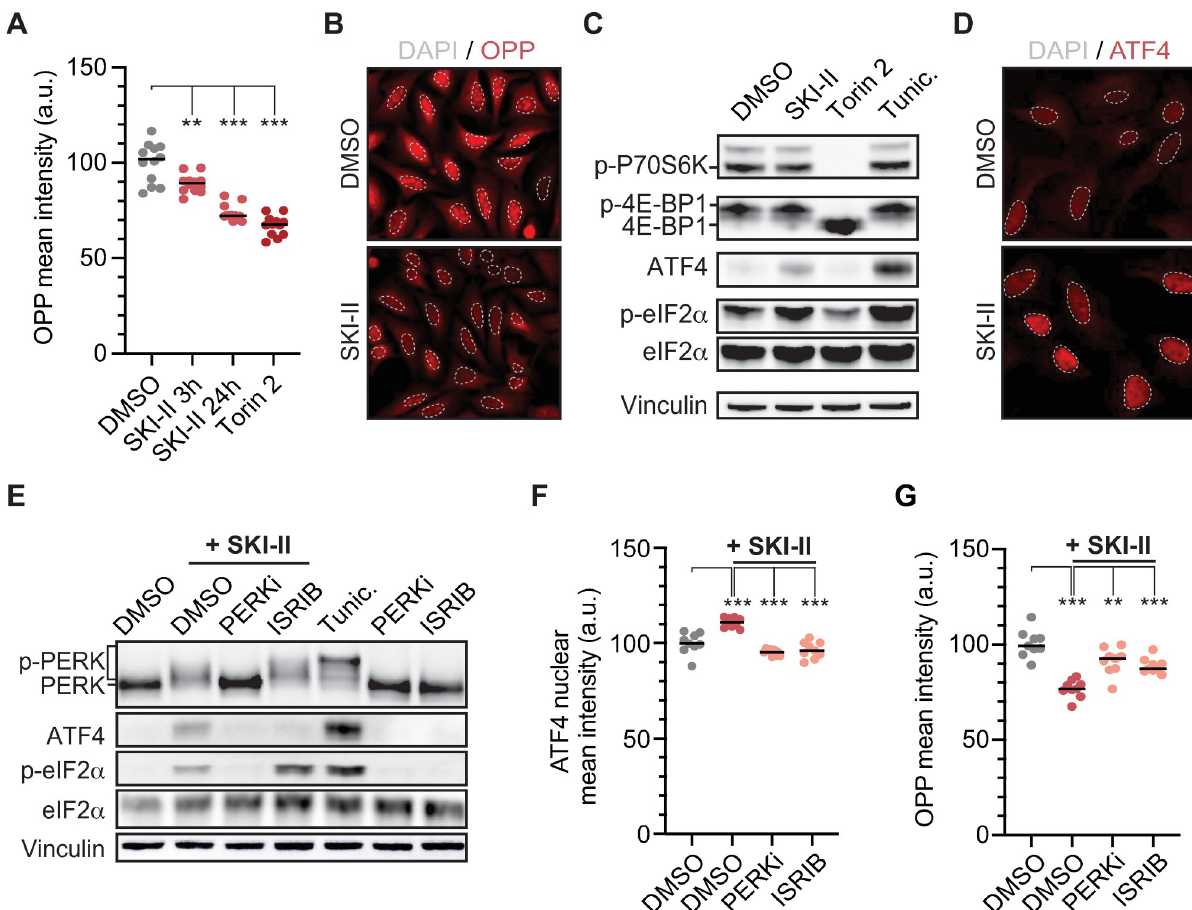
Fig 2. SKI-II reduces mRNA translation by activating the ISR. (A) HTM-mediated quantification of the mean intensity of OPP signal in U2OS cells exposed to SKI-II (10 μ M) at different time points (3 and 24 h). Torin 2 (0.5 μ M, 3 h) was included as a control. Data A in S2 Data. (B) Reduction in OPP signal (RED) in U2OS cells exposed to SKI-II (10 μ M) for 3 h compared to the DMSO control. Nuclei were stained with Hoechst (dashed GRAY line). (C) WB for markers of the mTORC1 (p-P70S6K and 4E-BP1) or ISR (p-eIF2 α and ATF4) pathways in U2OS cells exposed during 3 h to SKI-II (10 μ M), Torin 2 (0.5 μ M). The ISR-activating compound Tunic. (10 μ g/mL) or the mTORC1 inhibitor Torin 2 were used as controls (0.5 μ M, 3 h). Total levels of Vinculin and eIF2 α are shown for normalization. (D) Nuclear accumulation of ATF4 in U2OS cells exposed to SKI-II (10 μ M) for 3 h. (E) WB of markers of activation of the ISR (p-PERK, ATF4, and p-eIF2 α ) in U2OS cells preexposed for 1 h to PERK inhibitor (PERKi, 0.5 μ M) and ISRIB (50 nM) or DMSO, and then exposed to SKI-II (10 μ M) or DMSO for 3 h. The p-PERK is recognized as a shift in the migration pattern of the protein. (F) HTM-mediated quantification of ATF4 mean nuclear intensity in U2OS cells treated as in (E). Data F in S2 Data. (G) HTM-mediated quantification of OPP signal in U2OS cells treated as in (E). For the HTM-mediated quantifications, every dot represents the mean value of the measurements taken per well from 3 independent experiments. Data G in S2 Data. Statistical analyses were done using one-way ANOVA tests. ��� p < 0.001. 4E-BP1, 4E-binding protein 1; ATF4, activating transcription factor 4; DMSO, dimethyl sulfoxide; eIF2 α , eukaryotic translation initiation factor 2 subunit 1; HTM, high-throughput microscopy; ISR, integrated stress response; ISRIB, integrated stress response inhibitor; mTORC1, mechanistic target of rapamycin complex 1; OPP, o-propargyl-puromycin; p-eIF2 α , phosphorylated eIF2 α ; p-P70S6K, phosphorylated P70S6K; PERK, protein kinase RNA-like endoplasmic reticulum kinase; PERKi, PERK inhibitor; p-PERK, phosphorylated PERK; Tunic., Tunicamycin; WB, western blotting.